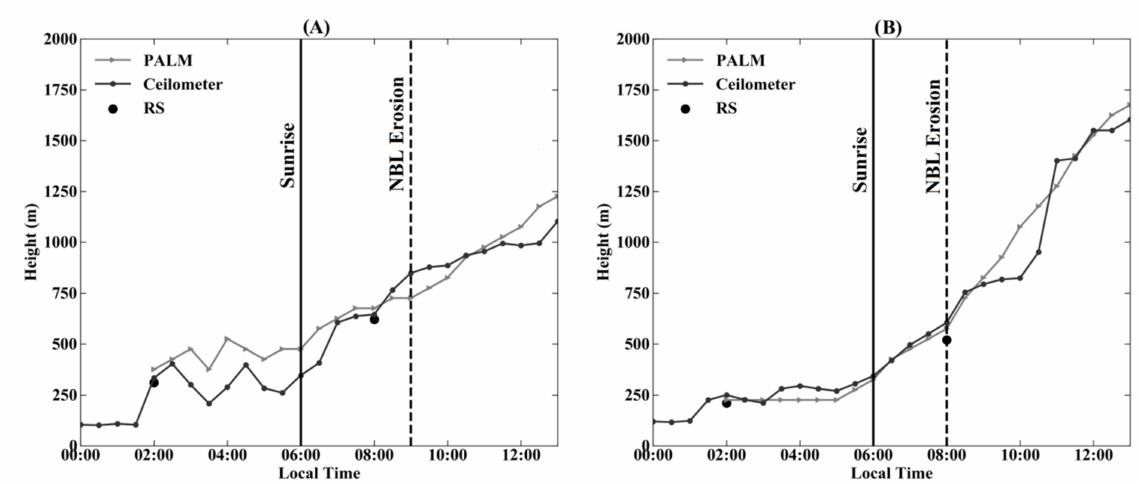
Figure 7. Heights of the PBL (m) over the GoAmazon site for ( A ) IOP 3 and ( B ) IOP 4. The vertical lines mark sunrise (continuous line) and the erosion of the NBL (dashed